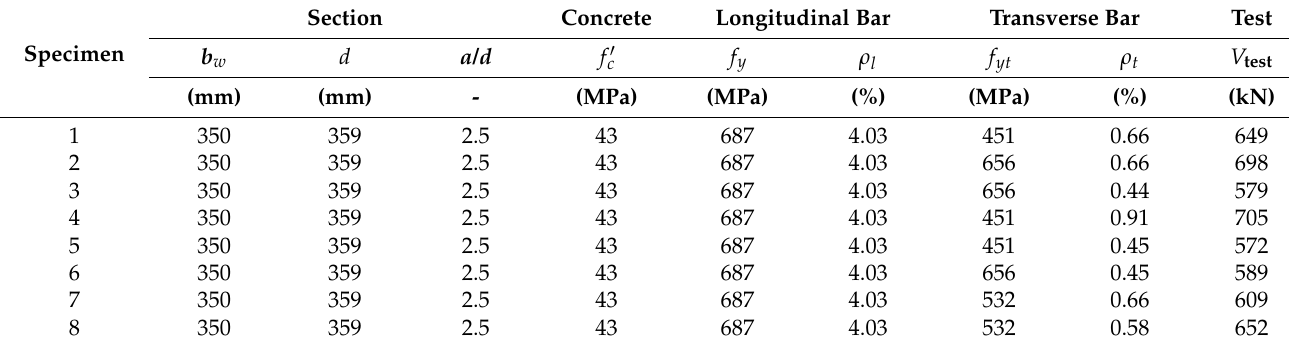
Table 3. Details of the validation set